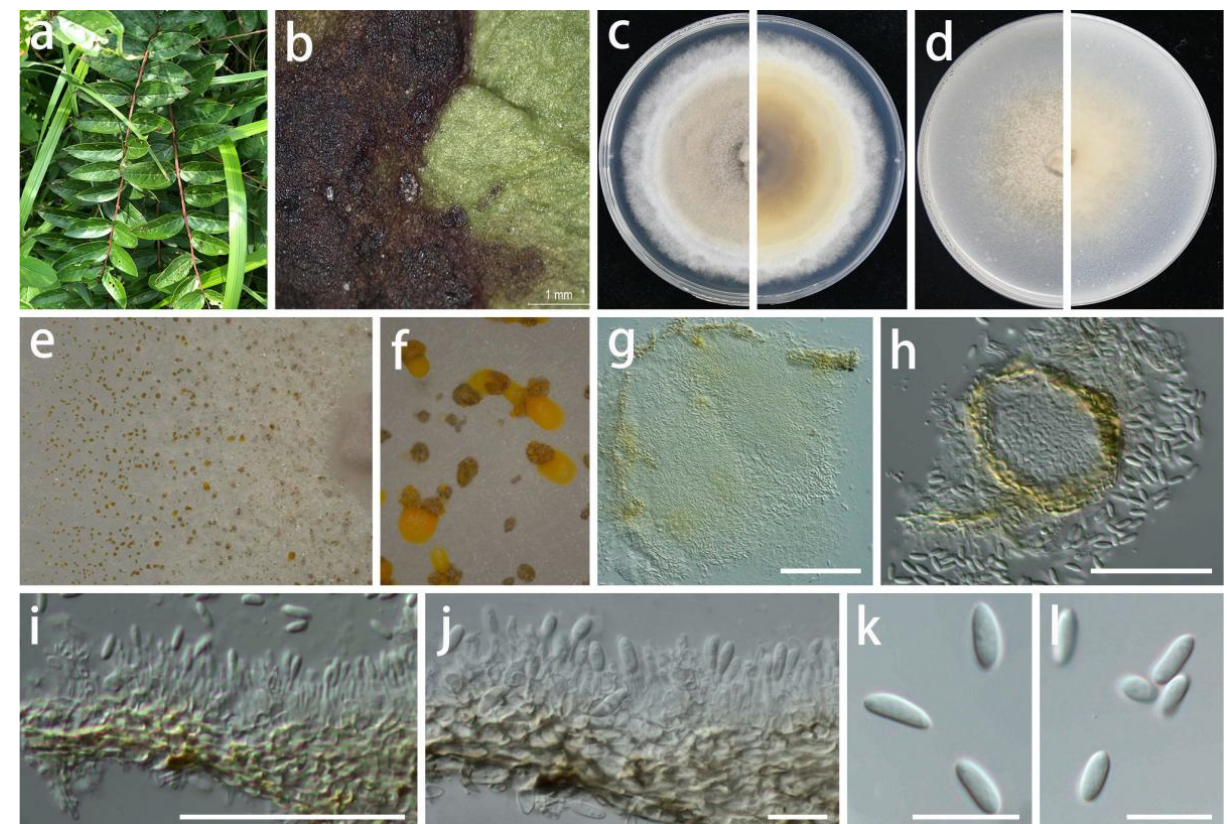
Figure 6. Chrysofolia coriariae (GUCC 416.4). ( a , b ) Host: Coriaria nepalensis . ( c ) Colony on PDA after 2 wk at 25 °C (left: above, right: reverse). ( d ) Colony on OA after 2 wk at 25 °C (left: above, right: reverse). ( e , f ) Conidial masses. ( g , h ) Conidiomata. ( i , j ) Conidiogenous cells. ( k , l ) Conidia. Scale bars: ( g – i ) = 50 μ m; ( j – l ) = 10 μ m.